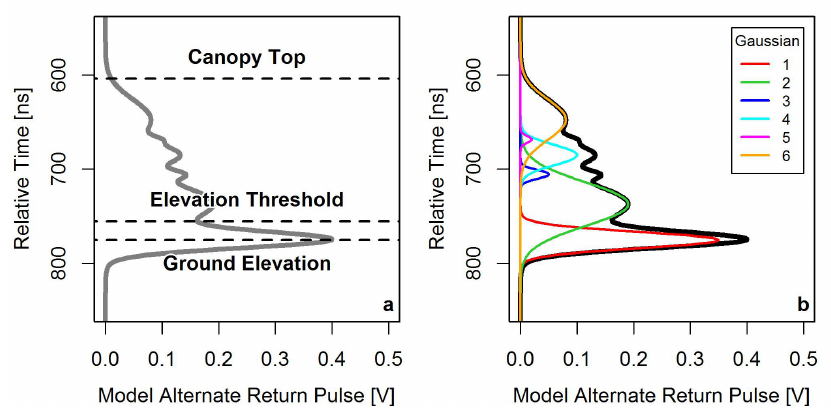
Figure 2. Example waveform indicating ( a ) the locations of the canopy top, ground elevation, and an example height threshold above the ground; and ( b ) the same waveform with fitted